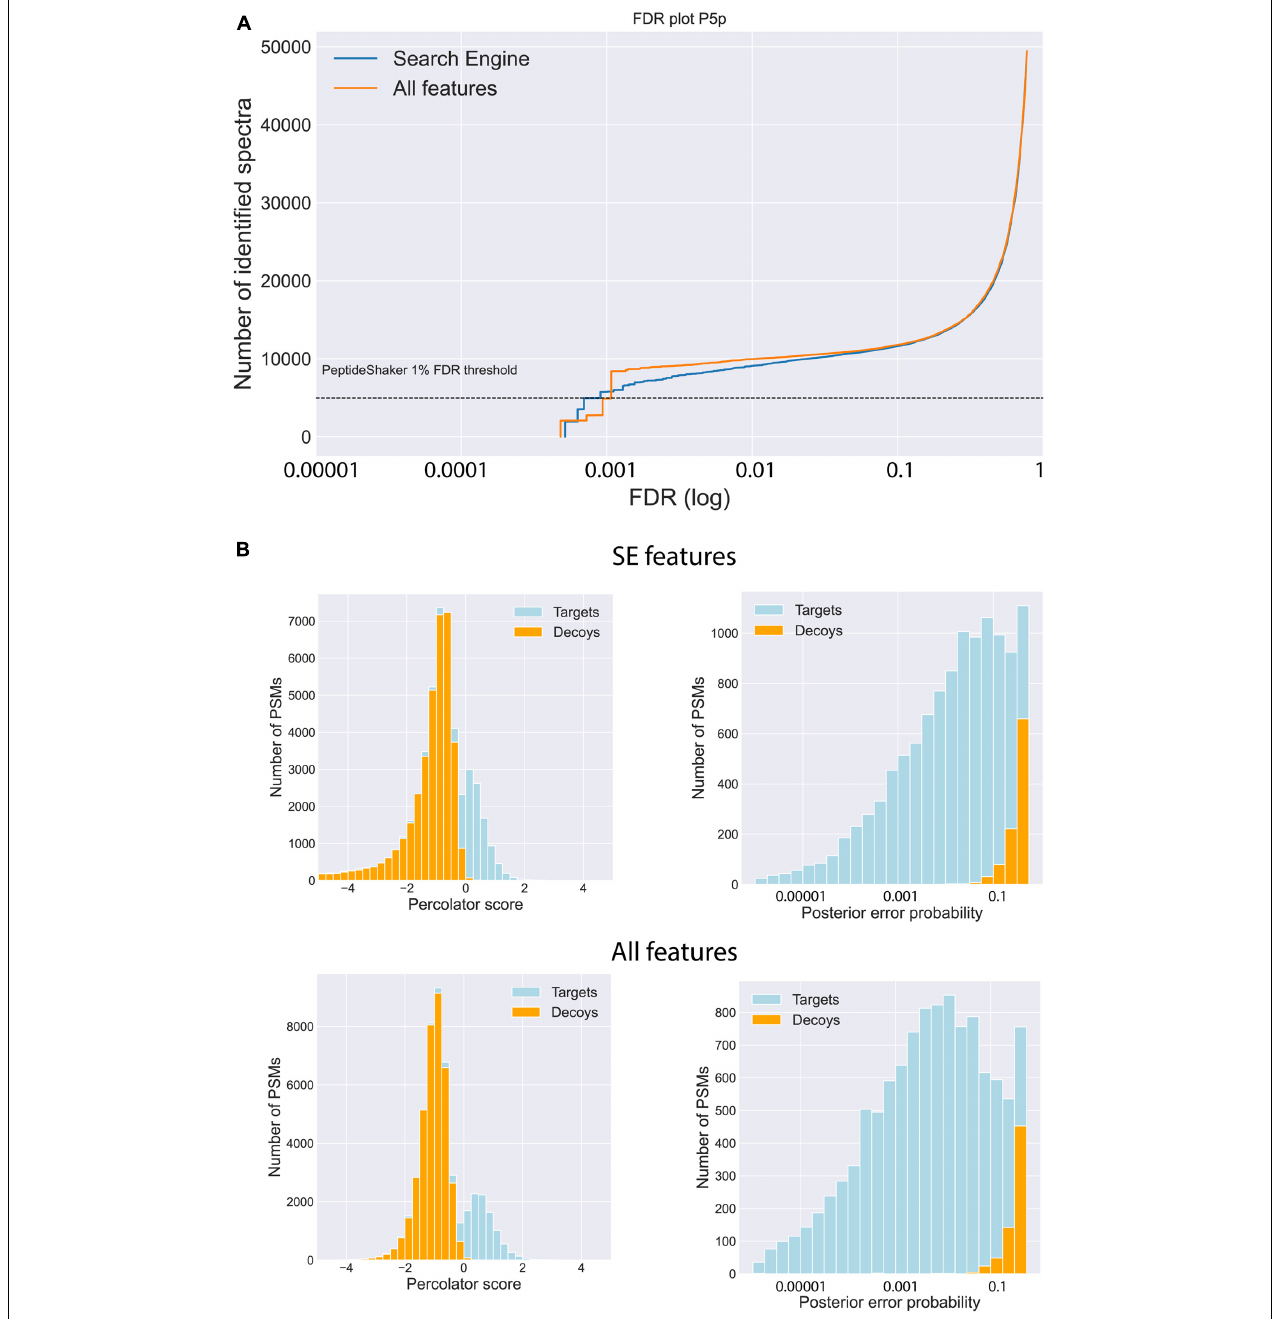
FIGURE 2 | Impact of feature prediction on PSM level. (A) Visualization of the number of identified spectra for a range of FDRs when using only the features generated by MSGF+ (Search Engine, blue) in Percolator and using the features of MSGF+ and the predicted features generated by MS 2 PIP and DeepLC (All features, orange) in Percolator. (B) Increased discrepancy power between targets and decoys is illustrated by an increase of the Percolator score of the target PSMs and decrease of the posterior error probability (PEP) when including all the features (bottom row) compared to solely the search engine features (upper row). (Data of posterior brain samples is shown, similar graphs for the other four brain samples are found in Suppl. Fig.